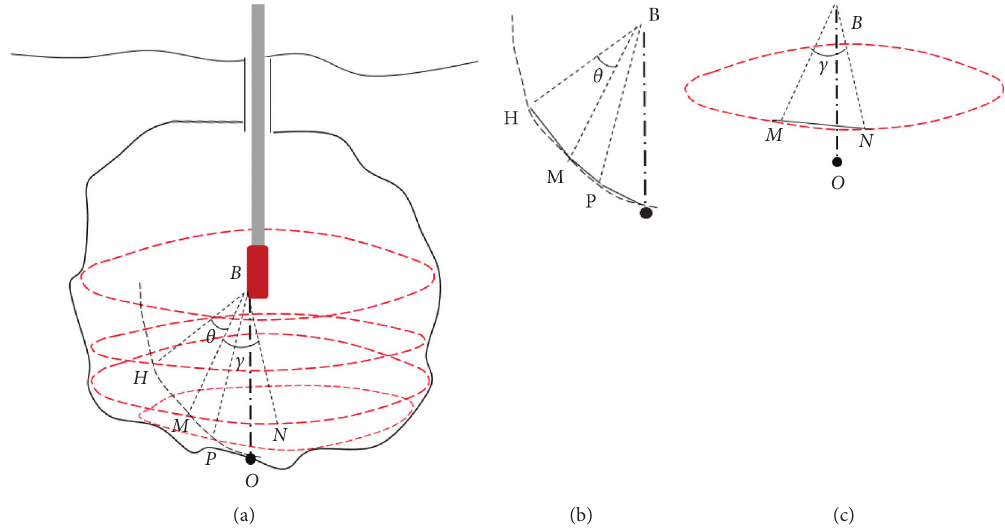
Figure 5: Laser scanning of a karst cavity. (a) 3D perspective. (b) Radial scan pattern. (c) Axial scan pattern.